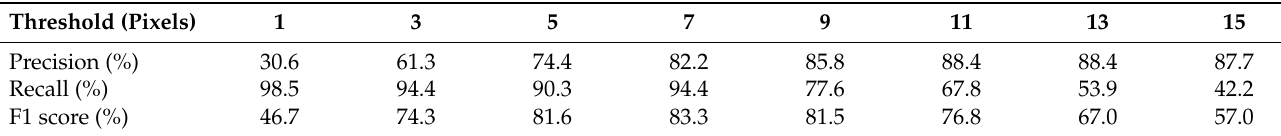
Table 3. Evaluation under different area